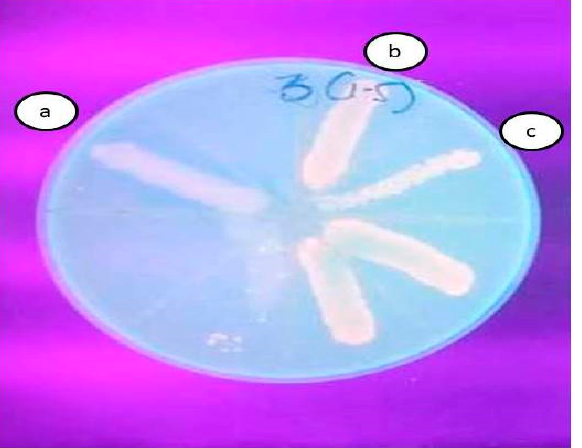
Figure 2. EPI activity of UA, as determined by the ethidium bromide agar cartwheel method, compared with CCCP in AI 7574. (a) Untreated; (b) treated with (+)-UA; (c) treated with CCCP. Compared with (a) (untreated), fluorescence is seen in (b) and (c).